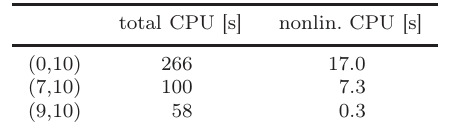
Table 2. CPU times for nonlinear Arnoldi with local